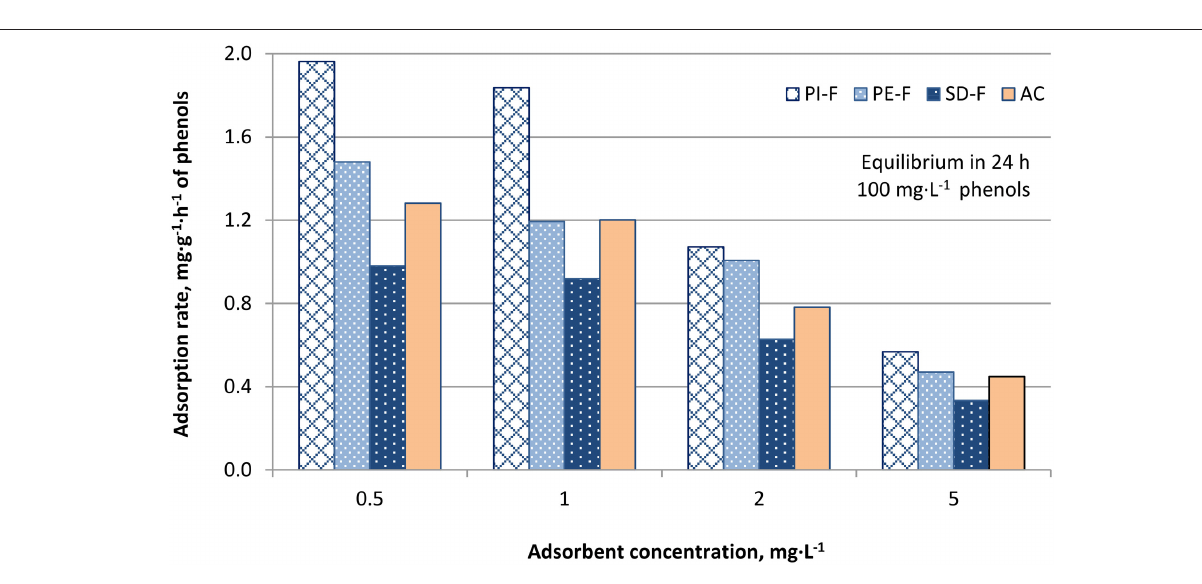
FIGURE 6 | Adsorption rates, mg · g − 1 · h − 1 , of phenols on biochars PI-F, PE-F, and SD-F for adsorbent concentration 0.5, 1, 2, and 5 g · L − 1 (AC: activated carbon, used as reference